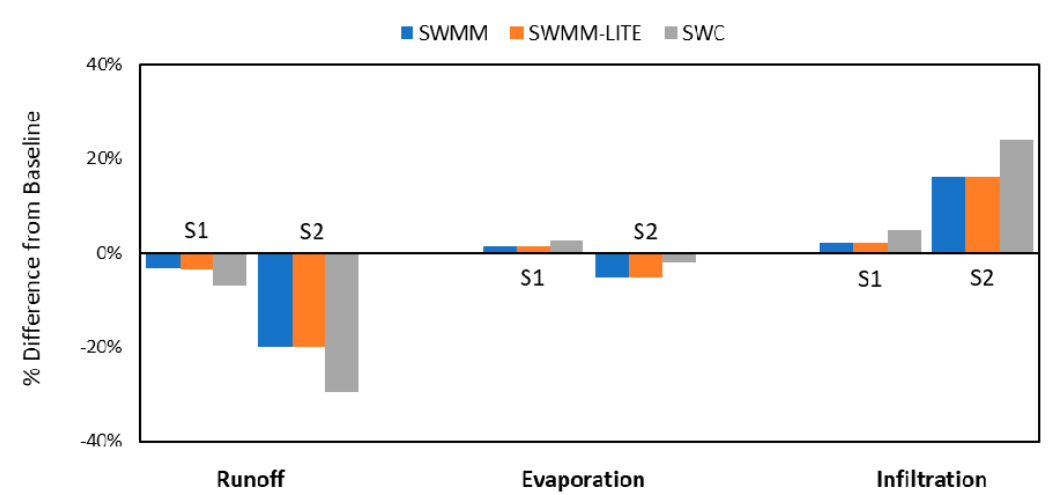
Figure 4. Evaluation of percent change from baseline for each hydrologic output when comparing different models.